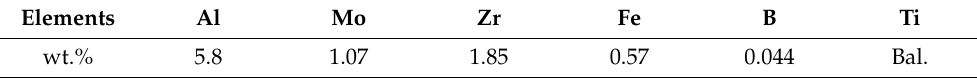
Table 1. Chemical composition of the near- α Ti-6Al-1Mo-2Zr-0.55Fe-0.1B (wt.%) alloy.